Question: Condense the content of this figure into a single sentence.
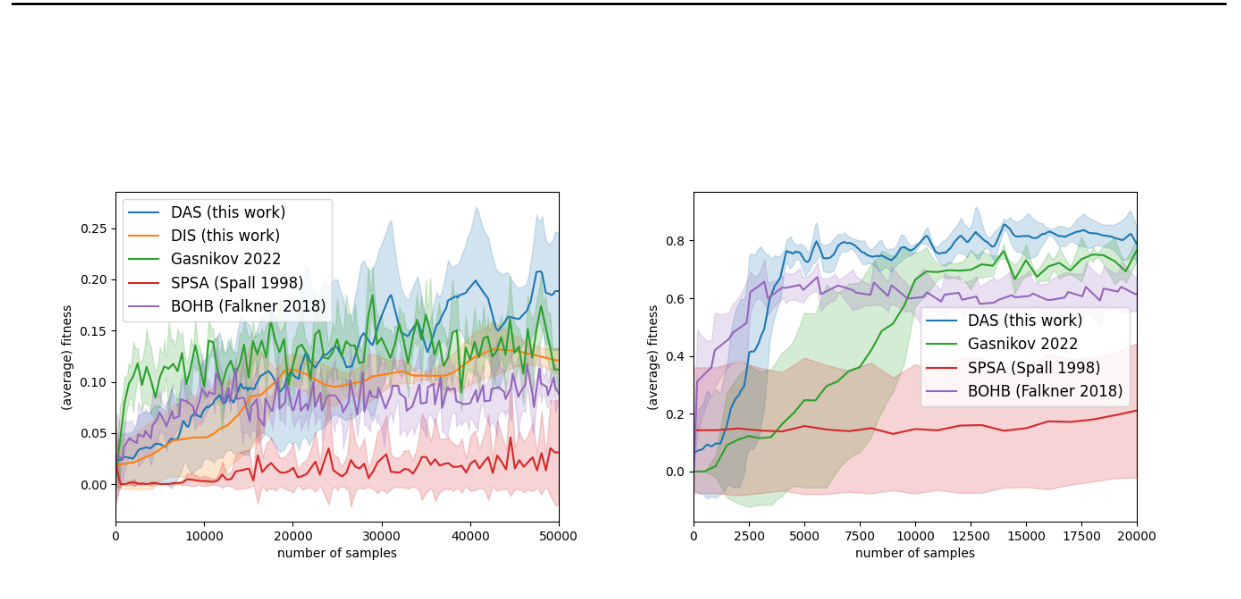
Answer: Left: Average success probability obtained by different tuning methods on random 3-SAT with N = 150, α = 4.0, T = 148. Averages are over 5 realizations of the tuning dynamics starting at different randomized positions. The shaded region represents one standard deviation of the data. To evaluate the fitness of each parameter configuration, 20 random SAT instances are generated and 50 trajectories are evaluated for each. Right: A similar plot for tuning an Ising solver on problem size N = 150 in which the performance improvement provided by DAS is clearer. This result is not discussed in the main text but is included in appendix C.5